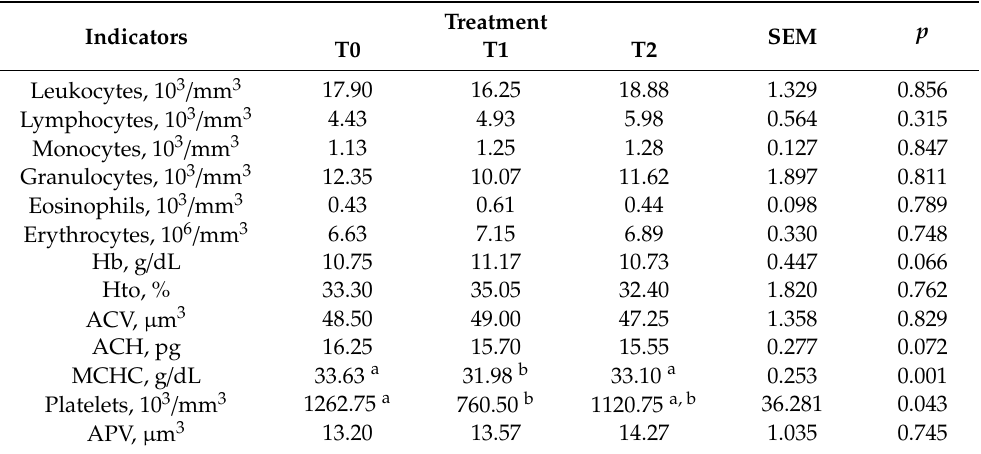
Table3. E ff ectoforaladministrationwith Lactobacillusplantarum CAM6onthehematologicalparameters of weaned